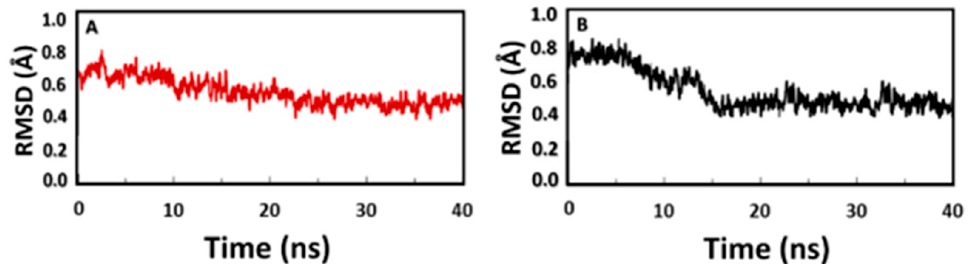
Figure 5. Molecular dynamics results of: ( A ) naproxen; ( B ) derivative 1 .